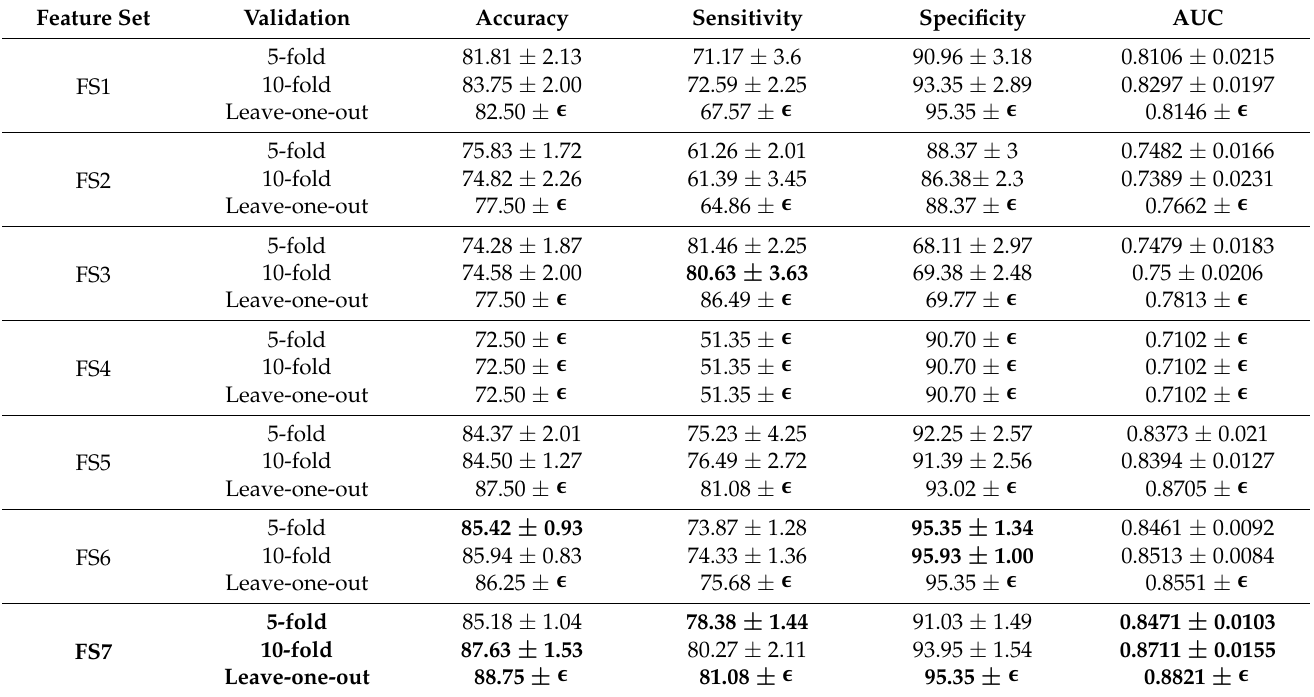
Table 4. Comparison of experimental results of classification accuracy (%), sensitivity (%), specificity (%), and AUC (in terms of mean ± standard deviation) using the proposed SVM classification model, where 𝛜 indicates 1.0 × 10 − 5 .